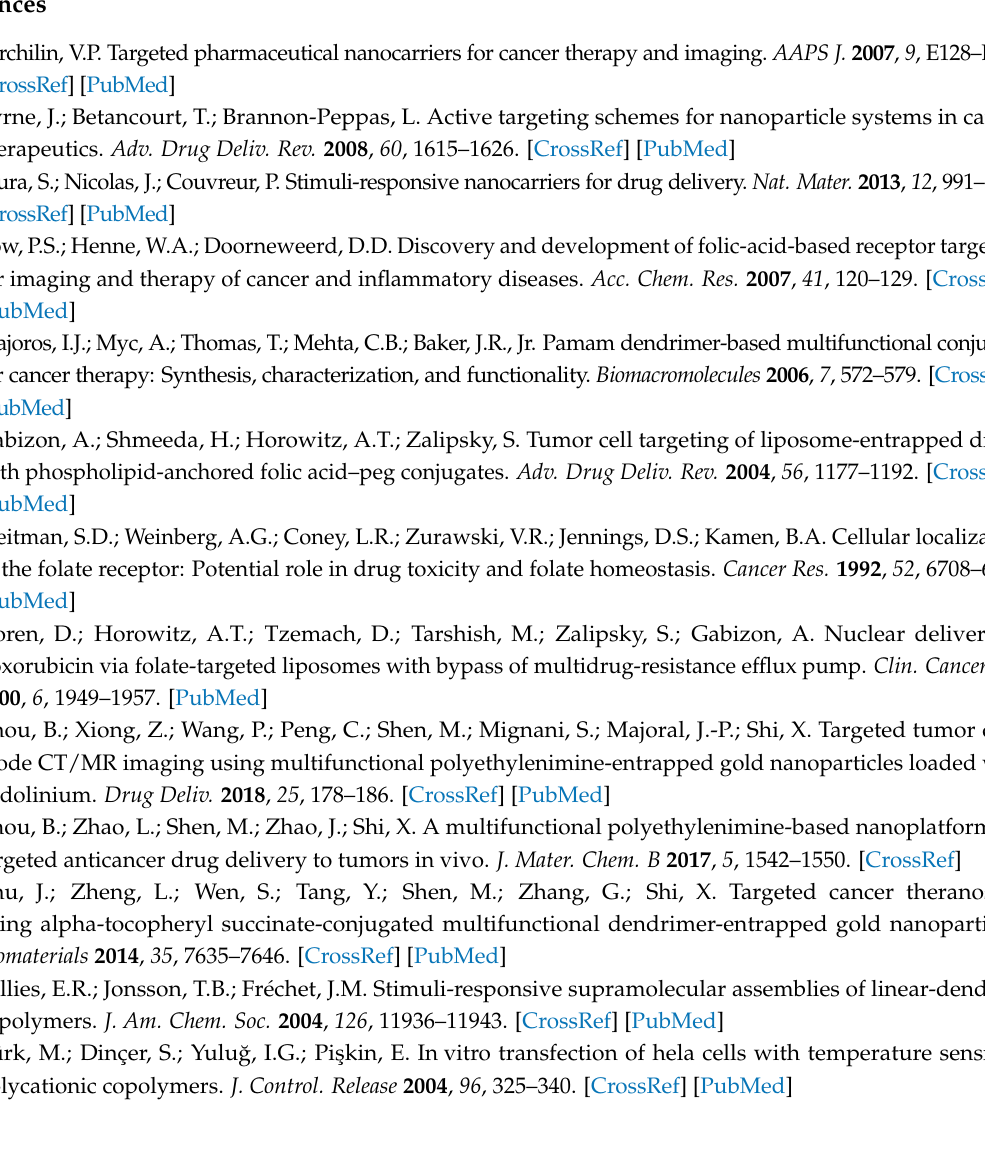
Figure S1: 1 H NMR spectrum of G5.NHAc-FA dendrimers, Figure S2: FTIR spectra of DOX and CA-DOX, Figure S3: HPLC chromatograms of (a) DOX · HCl and (b) CA-DOX, Figure S4: Phase contrast microscopic images of KB cells treated with (a) 10 µ L PBS, (b) G5.NHAc-DOX conjugates in 10 µ L PBS (50 µ M DOX-equiv), (c) G5.NHAc-FA-DOX conjugates in 10 µ L PBS buffer (50 µ M DOX-equiv), (d) free DOX in 10 µ L PBS (1 µ M), and (e) G5.NHAc-FA dendrimers in 10 µ L PBS,